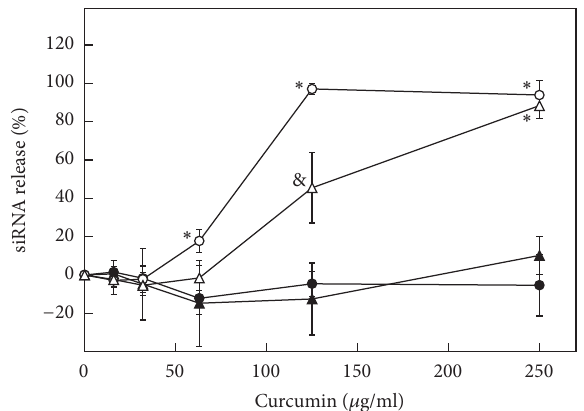
Figure 4: Effect of temperatureon the releaseof siRNA from DOPC or DOPC/Cholesterol liposomes induced by curcumin. DOPC or DOPC/Cholesterol liposomes were treated with curcumin at the indicated concentrations for 30min at room temperature or 60 ∘ C, respectively. Symbols indicate the following: e , DOPC liposomes treated at room temperature; I , DOPC liposomes treated at 60 ∘ C; △ , DOPC/Cholesterol liposomes treated at room temperature; 󳵳 , DOPC/Cholesterol liposomes treated at 60 ∘ C. Assays were done in triplicate and data were represented as mean values and standard errors (vertical bars). Percentages of siRNA release were expressed as relative values with Triton X-100-treatedsamples defined as 100% and DMSO-treated samples as 0%. The results of Student’s 𝑡 -test in comparison of each sample treated with curcumin to control are expressed as 𝑝 values with symbols (&: < 0.05; ∗ : < 0.01) in the figure,